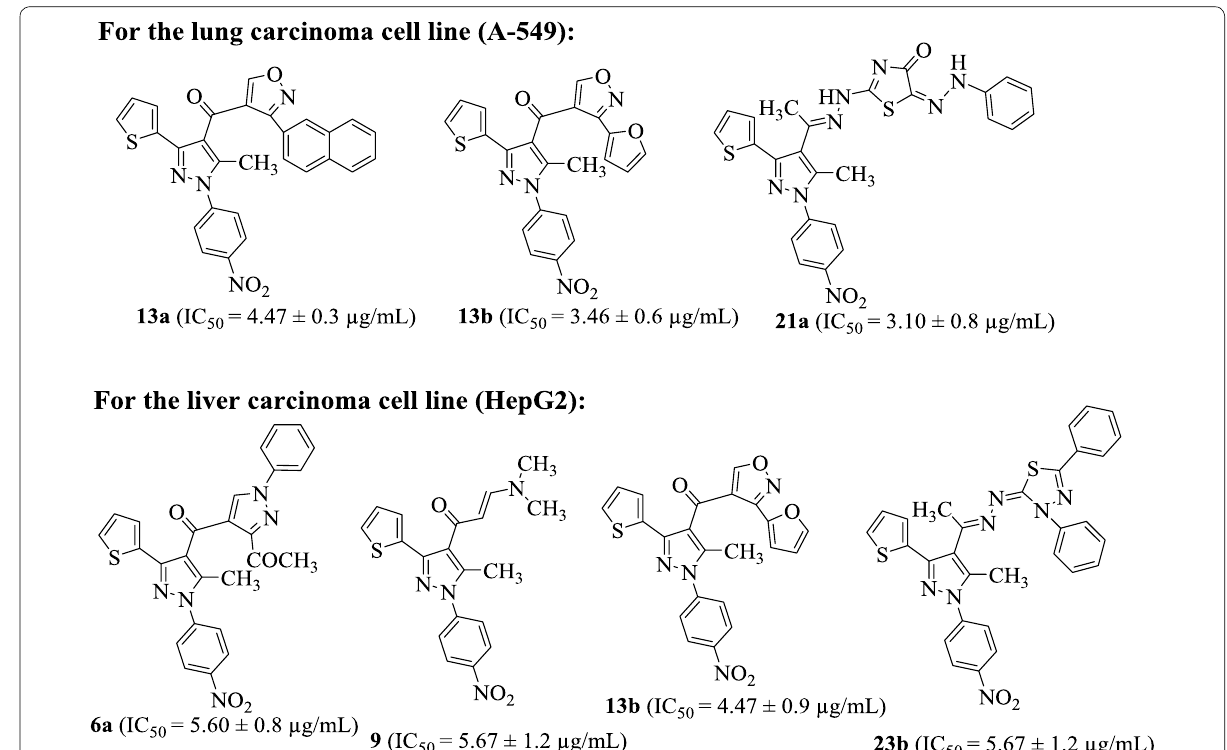
Fig. 1 Cytotoxic activities of the most active compounds against HEPG2 and A-549 cell